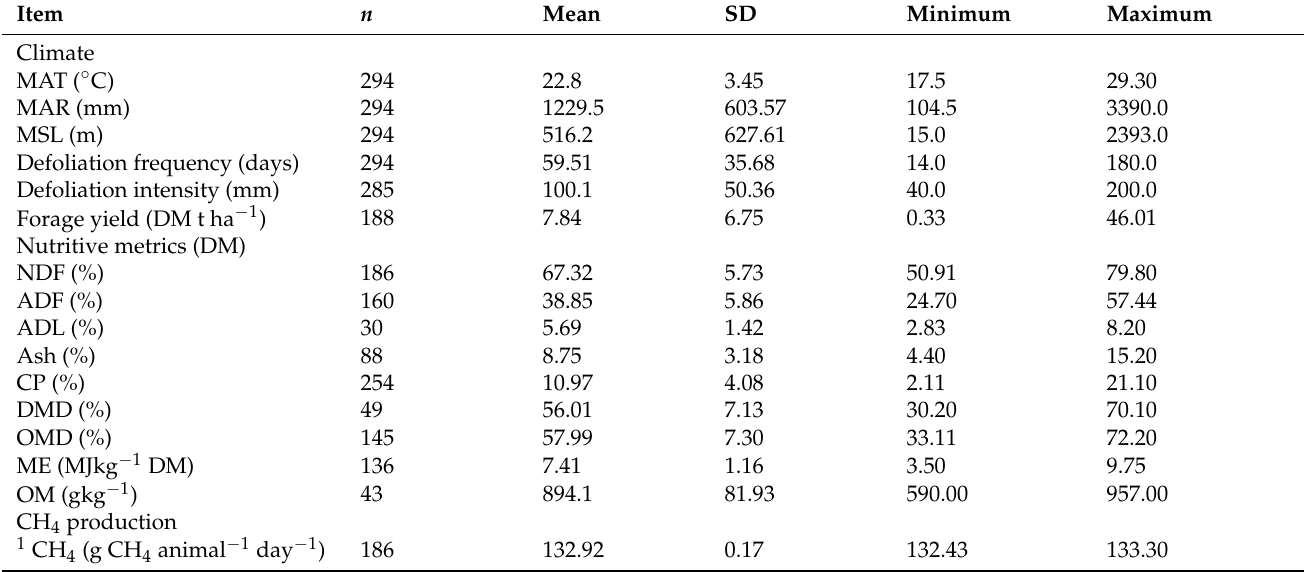
Table 1. Descriptive statistics of key variables.